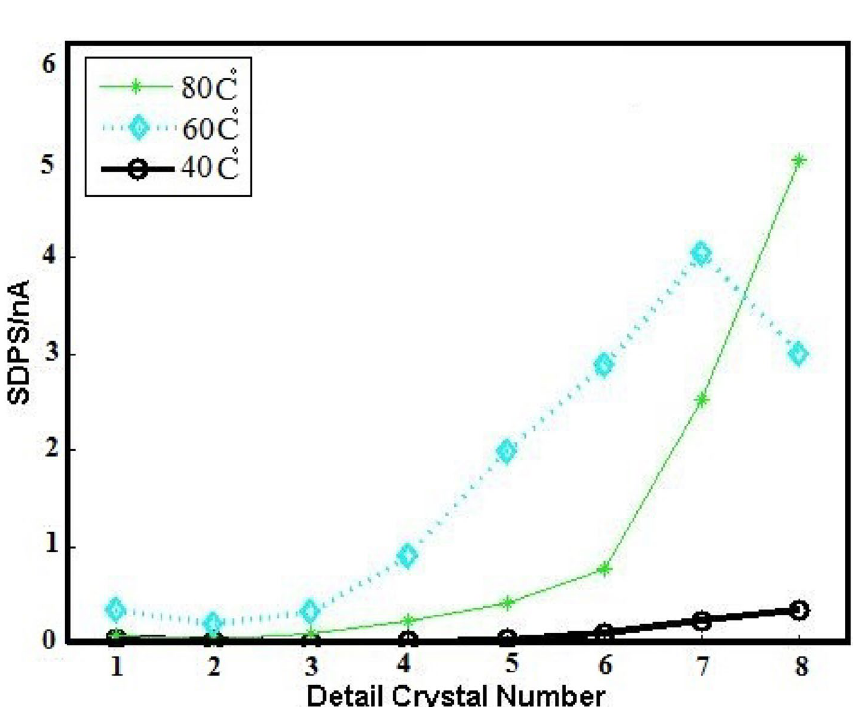
Figure 8. SDPS plots of Asy electrodes ECN signals in 0.3 M NaCl + 0.3 M Na 2 SO 4 solution at 40, 60 and 80